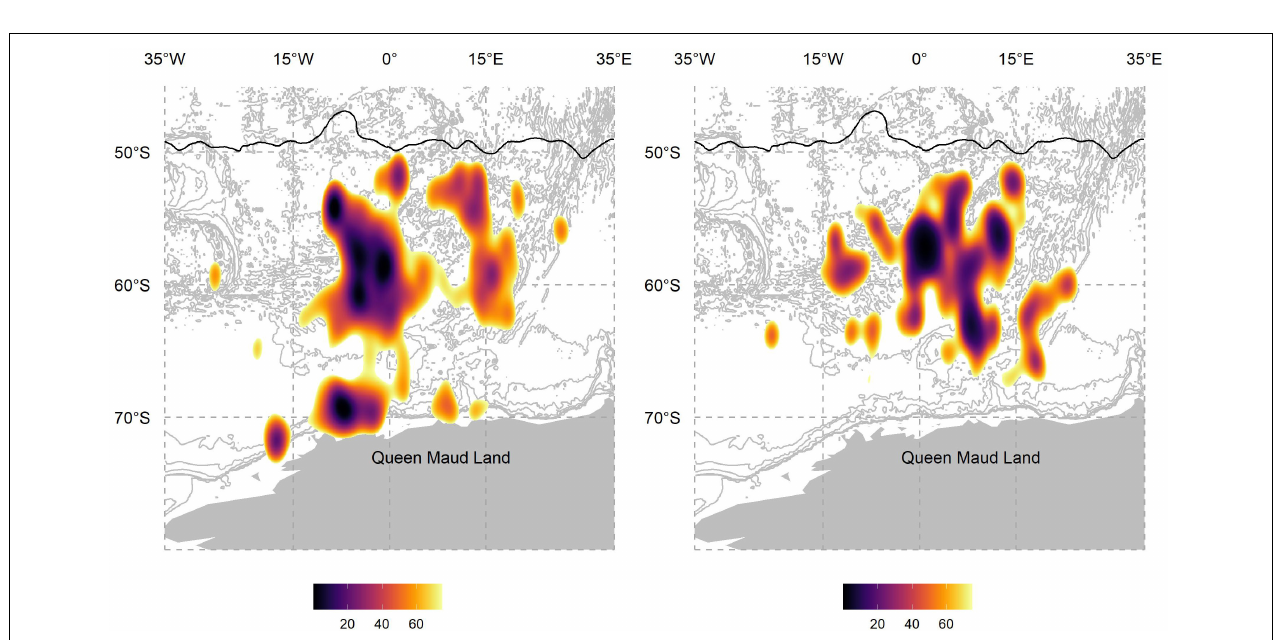
FIGURE 2 | The summer (left) and winter (right) percentage utilisation distributions for 19 Ross seals are shown in relation to the Polar Front (black line) (Orsi et al., 1995) and the Antarctic Continent. The grey lines are GEBCO 1 arc-min bathymetrical contours (IOC et al., 2003).